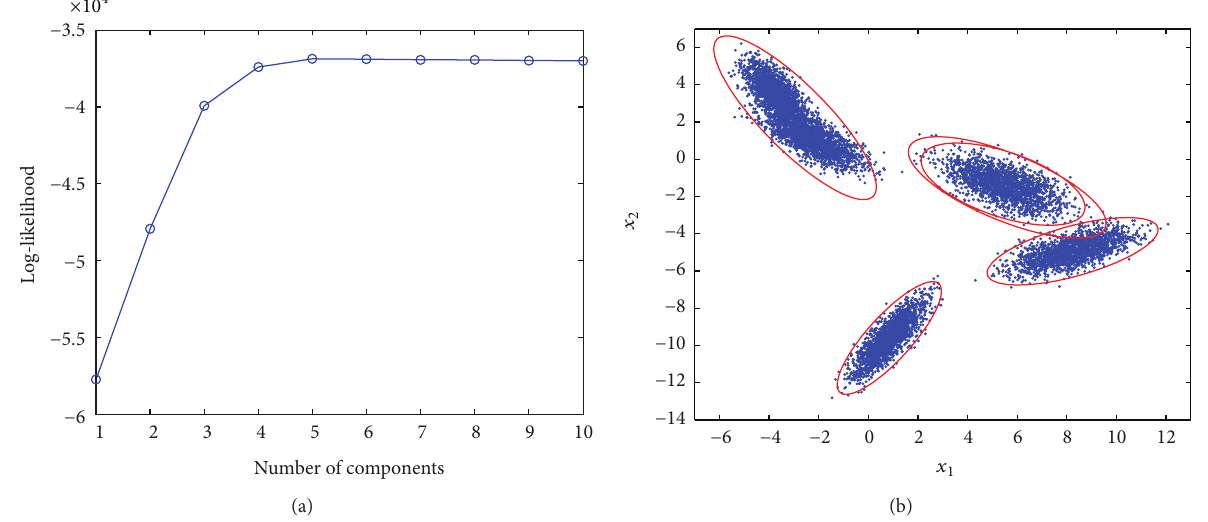
Figure 2: Log-likelihood with the penalty term (a) and an identified GMM model (in red) converged to a local maximum (b).